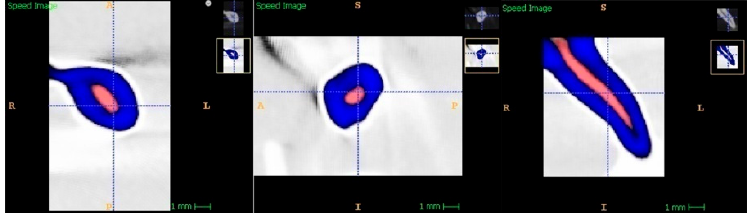
Figure 3. Multiplanar images of a single primary root canal.